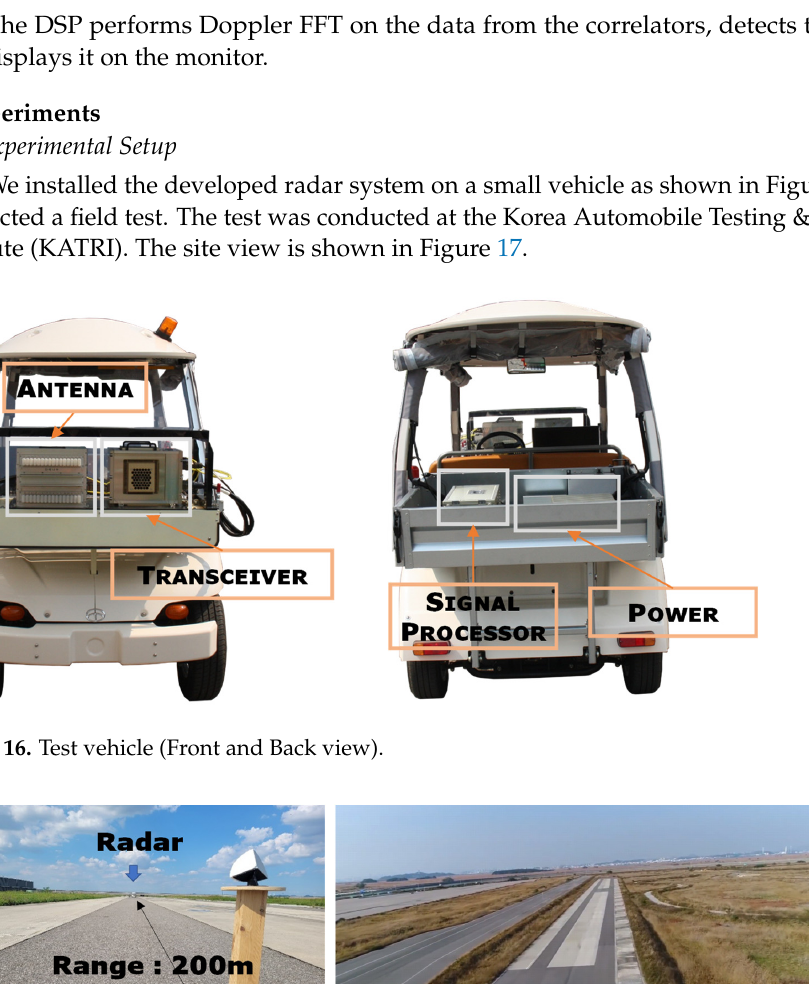
Figure 15. Digital correlator ( left ) and DSP signal processing board ( right ).